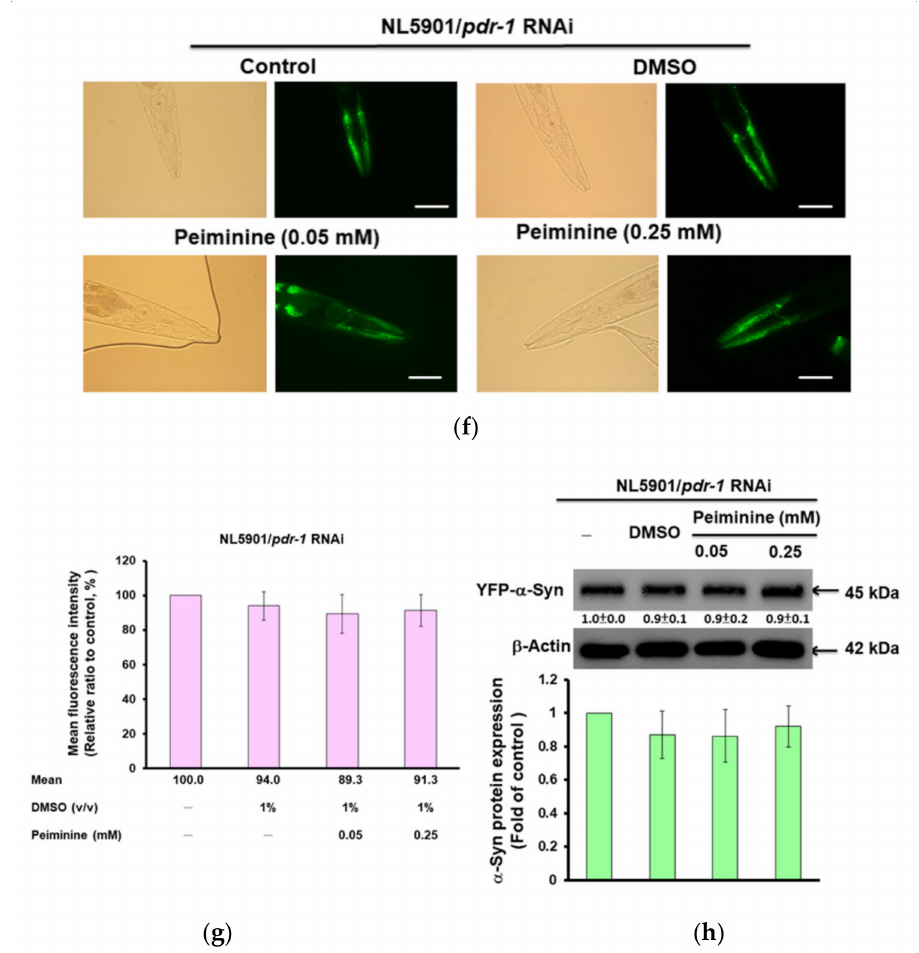
Figure 7. Using RNA interference (RNAi) to down-regulate the mRNA expression of pdr-1 can abolish the ability of peiminine (PMN) to improve the pathology of Parkinson disease in worm models. In the 6-OHDA-exposed BZ555 model, L1 stage worms were transferred to pdr-1 RNAi/NGM plates with or without PMN and grown to the L3 stage, exposed to 6-OHDA for 1 h, and then transferred to pdr-1 RNAi/NGM/FUDR plates with or without PMN and cultured for another 3 days for analysis. In the transgenic NL5901 model, L1 stage worms were cultured on pdr-1 RNAi/NGM plates with or without PMN for 1 day and then transferred to pdr-1 RNAi/NGM/FUDR plates with or without PMN and cultured for 3 days. ( a ) The relative level of pdr-1 mRNA in pdr-1 RNAi-treated BZ555 worms was determined by qPCR. * Indicates a significant difference between the prd-1 RNAi group and the control RNAi group (*** p < 0.001). ( b ) Representative fluorescence images of GFP expression patterns in DA neurons of BZ555 worms in each group. Scale bar = 50 µ m. ( c ) ImageJ software was used to quantify the fluorescence intensity of the GFP image in ( b ) ( n = 50). (d) The DA neuron degeneration phenotype defects of each group in ( b ) were scored. The data are represented as a percentage of the total population of worms with defective DA neuron phenotypes. # Indicates a significant difference between the 6-OHDA-exposed group and the control group ( # p < 0.001). ( e ) The relative level of pdr-1 mRNA in pdr-1 RNAi-treated NL5901 worms was determined by qPCR. * Indicates a significant difference between the prd-1 RNAi group and the control RNAi group (*** p <0.001). ( f ) Representative YFP fluorescence images of the accumulation of α -synuclein in the head muscles of worms in each group. Scale bar = 50 µ m. ( g ) ImageJ software was used to quantify the YFP fluorescence intensity of each group ( n = 50) in ( f ). # Indicates a significant difference between the PMN-treated group and the PMN-untreated group ( # p < 0.001). ( h ) The protein levels of α -synuclein in each group were analyzed by Western blotting. The loaded internal control is the level of β -actin. The image shows representative data from one of three independent experiments. The relative ratio is represented as the ratio of the level of α -synuclein in each group to that in the PMN-untreated